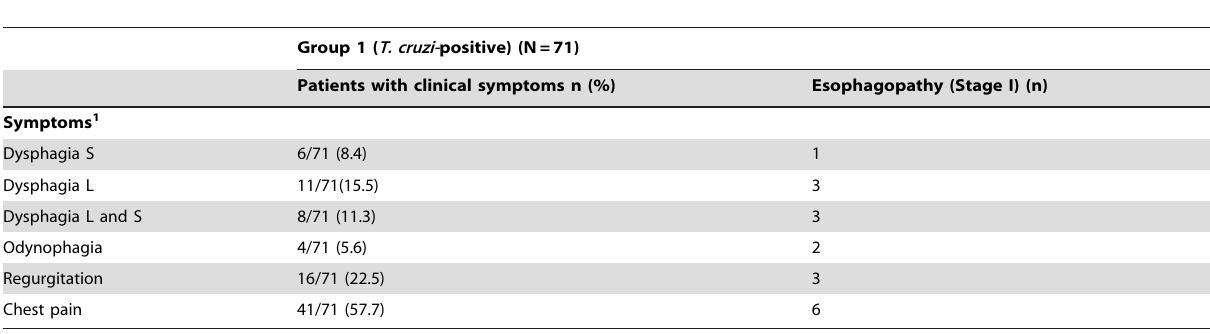
Table 3. Signs and symptoms of esophagopathy and association with esophagogram findings.